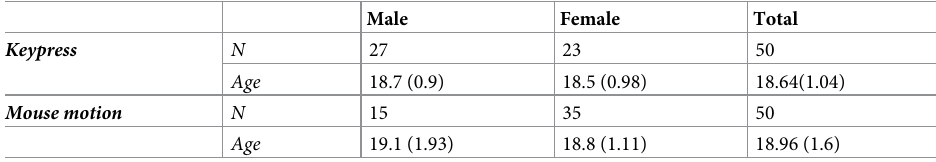
Table 10. Participants’ demographic